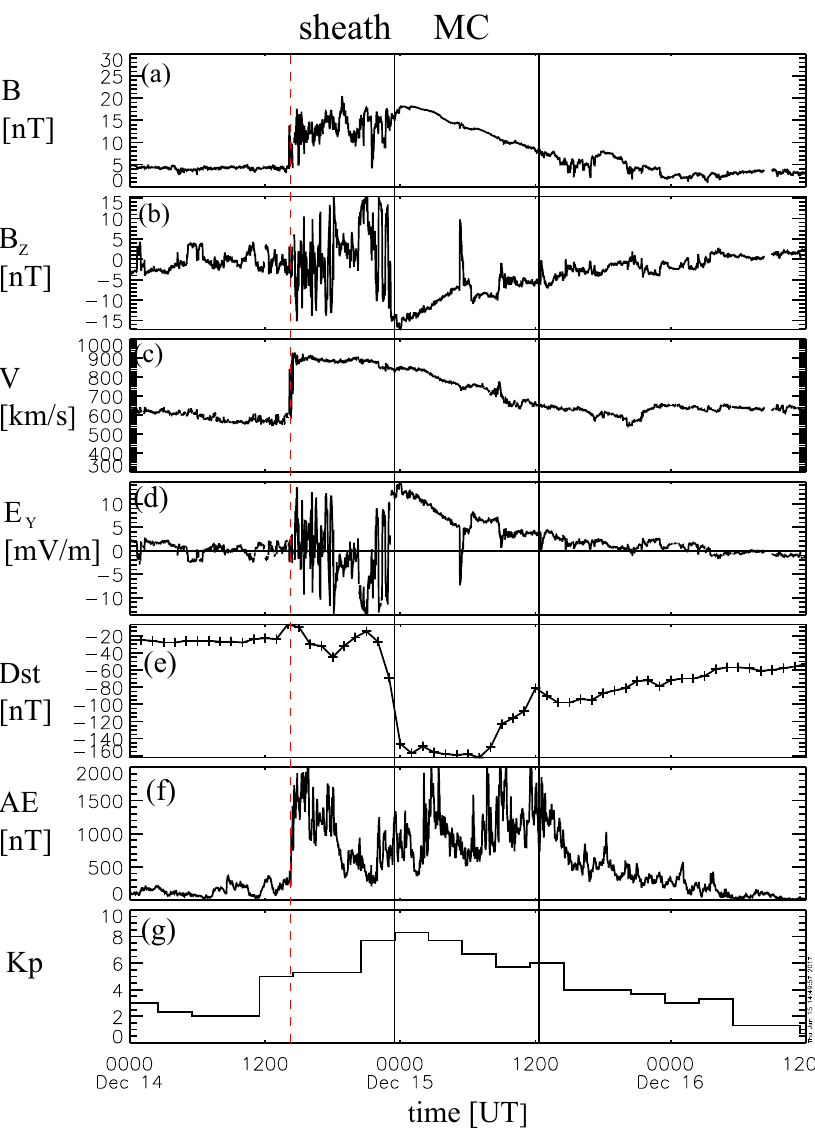
Fig.31 ExampleofasheathandamagneticclouddrivinggeomagneticactivityonDecember14–16,2006. The panels show from top to bottom: a magnetic field magnitude, b magnetic field north-south component (in GSM coordinates), c solar wind speed, d solar wind dawn-dusk electric field, e Dst, f AE (see Sect. 6.2) and g Kp. The data are 1-min OMNI data, Dst is 1-h average and Kp 3-h average. The dashed red line marks the shock and the pair of solid lines marks the MC